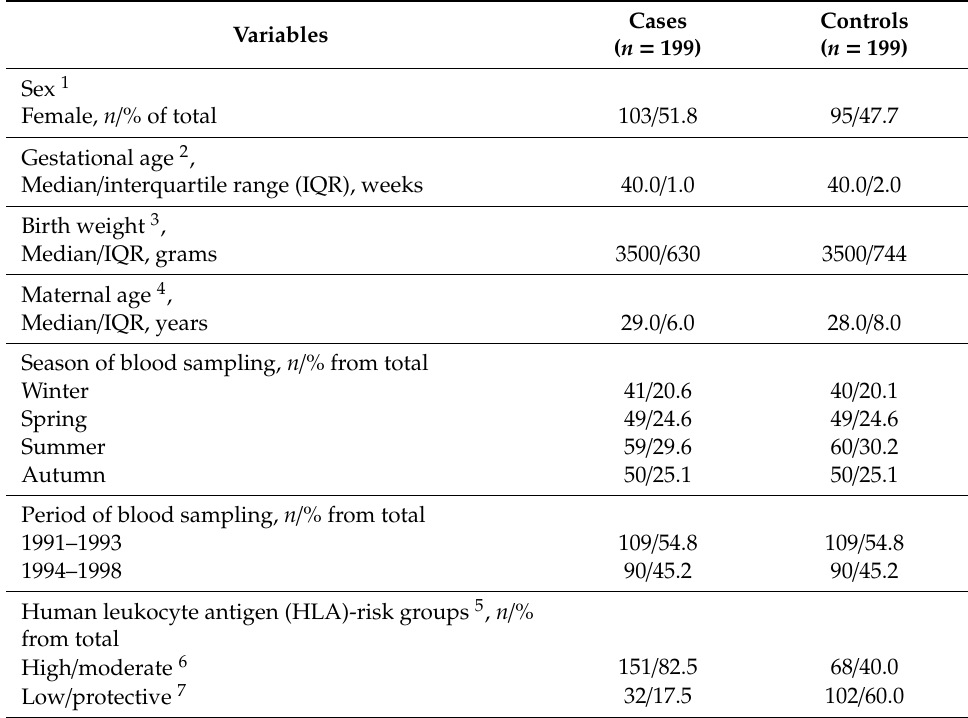
Table 1. Characteristics of the study sample (including specification of missing values). Cases are children who developed childhood type 1 diabetes (T1D), and controls who did not develop T1D during